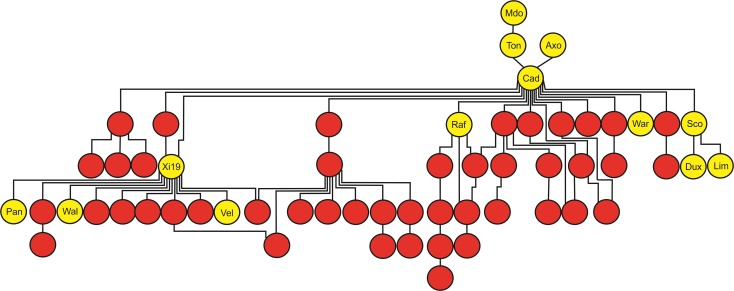
Tracking the transmission of SnToxA sensitivity in the wheat pedigree around the Axona × Tonic pedigree. SnToxA sensitive (score ≥ 3) = yellow. SnToxA insensitive (score < 1) = red. Variety names listed only for SnToxA sensitive varieties in the pedigree: Mdo = Maris Dove, Ton = Tonic, Axo = Axona, Cad = Cadenza, Raf = Raffles, War = Warlock_24, Sco = Scorpion_25, Dux = Duxford, Lim = Limerick, Pan = Panorama, Wal = Walpole, Vel = Velocity, and Cur = KWS Curlew.